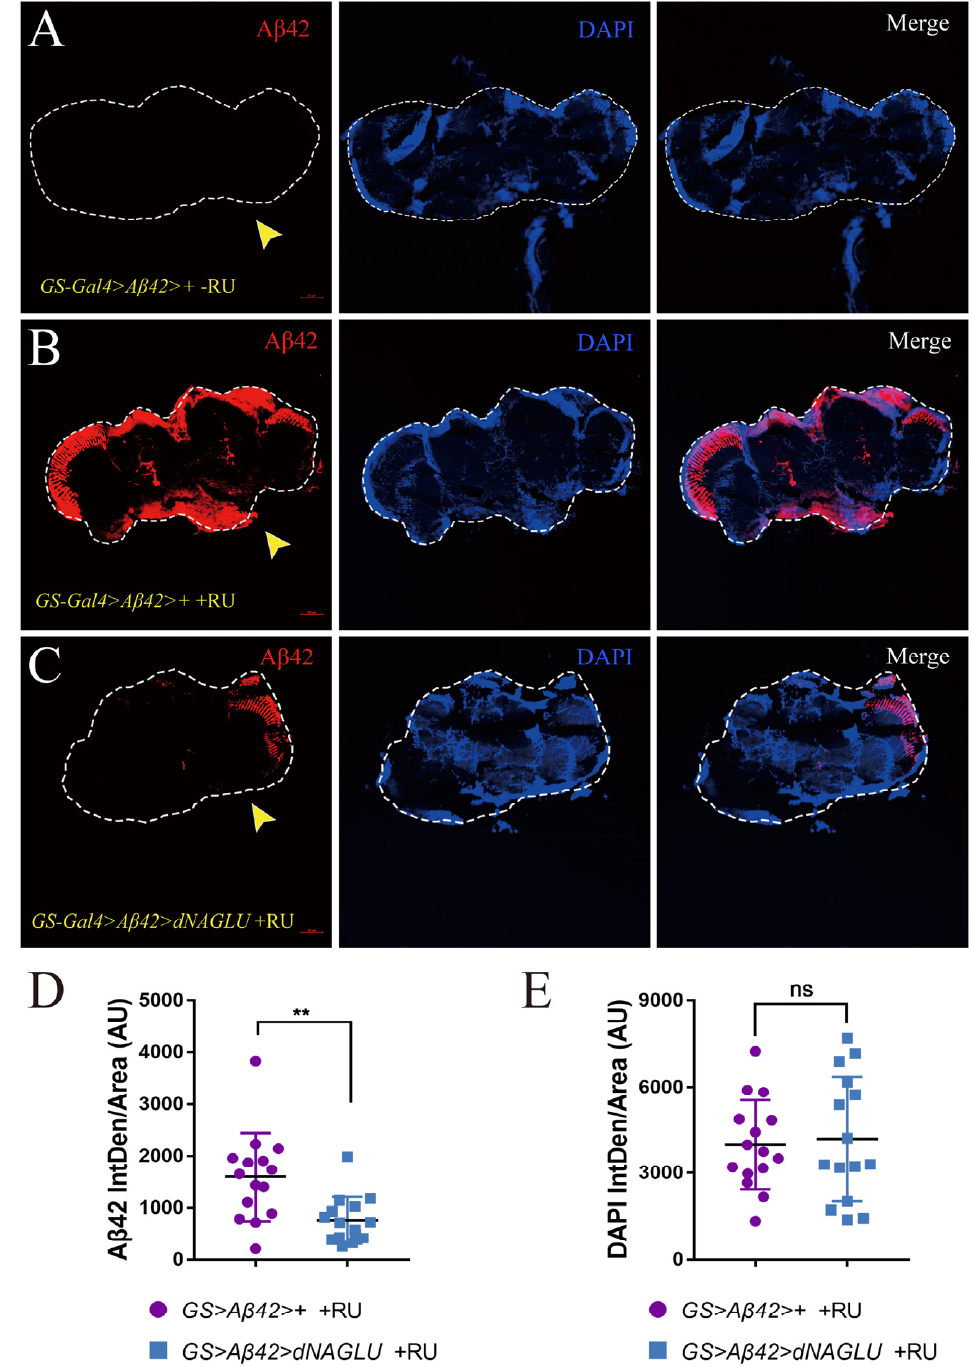
Figure 4. Overexpression of dNAGLU reduced A β 42 deposition in the mushroom body in AD Drosophila : ( A – C ) Immunofluorescence using β -amyloid antibody in Drosophila brain slices; ( A ) GS-Gal4>A β 42>+ − RU flies; ( B ) GS-Gal4>A β 42> + +RU flies; ( C ) GS-Gal4>A β 42>dNAGLU +RU flies; ( D ) the integrated density of A β 42/area are shown as bar plots ( n = 15, p = 0.0024, t -test); ( E ) the integrated density of DAPI/area are shown as bar plots ( n = 15, p = 0.7780, t -test). The nuclei are stained with DAPI in blue. ** p < 0.01, ns represents non-significant.